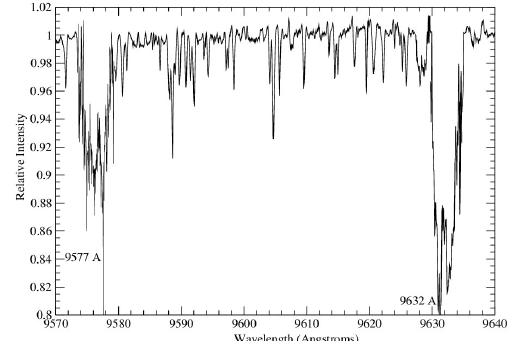
Figure 1: The two near IR bands in the spectrum of IRAS01005+7910, attributed to the cation of C 60 (Iglesias-Groth & Esposito